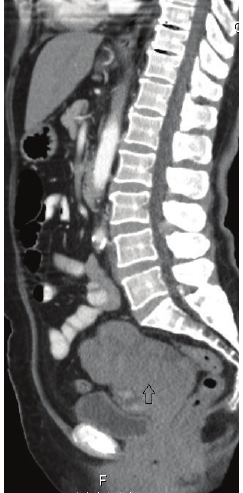
Figure 1: A CT scan showing a large mass of the left